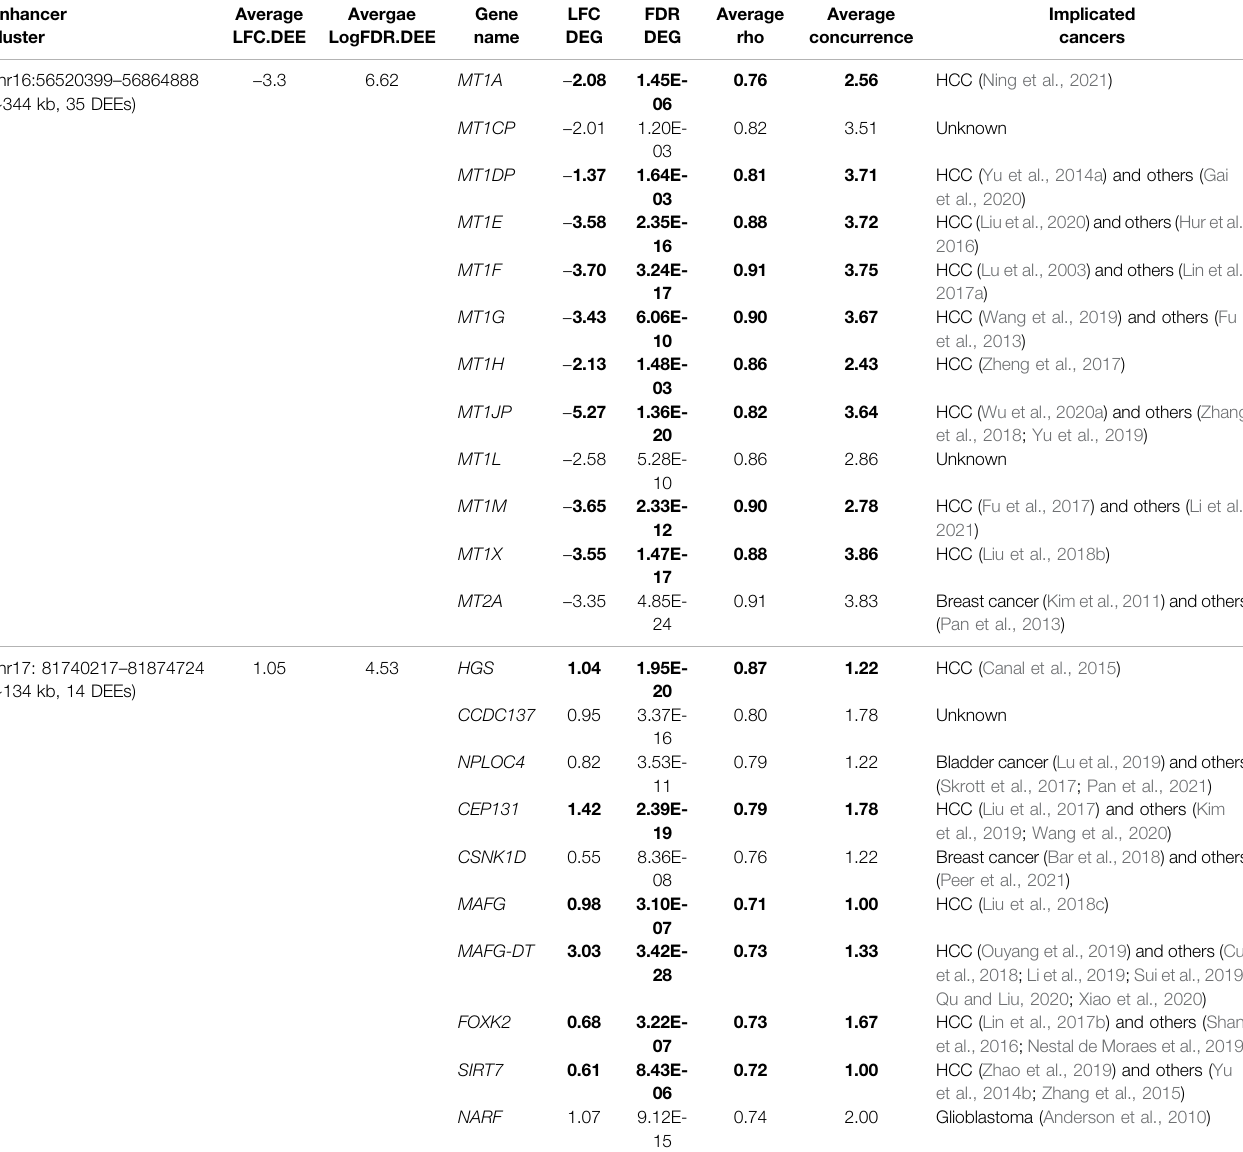
TABLE 2 | Summary information about two representative sets of DEE-DEGs regulated by intergenic DEE clusters. Enhancer cluster